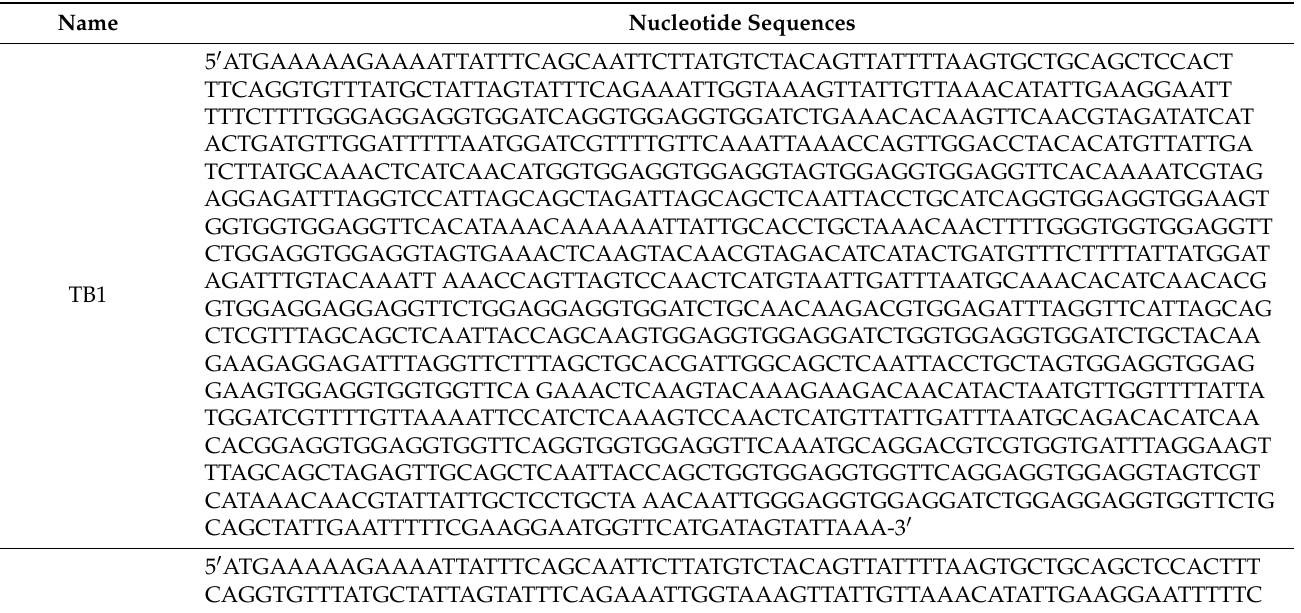
Table 3. Nucleotide sequences of recombinant proteins and oral